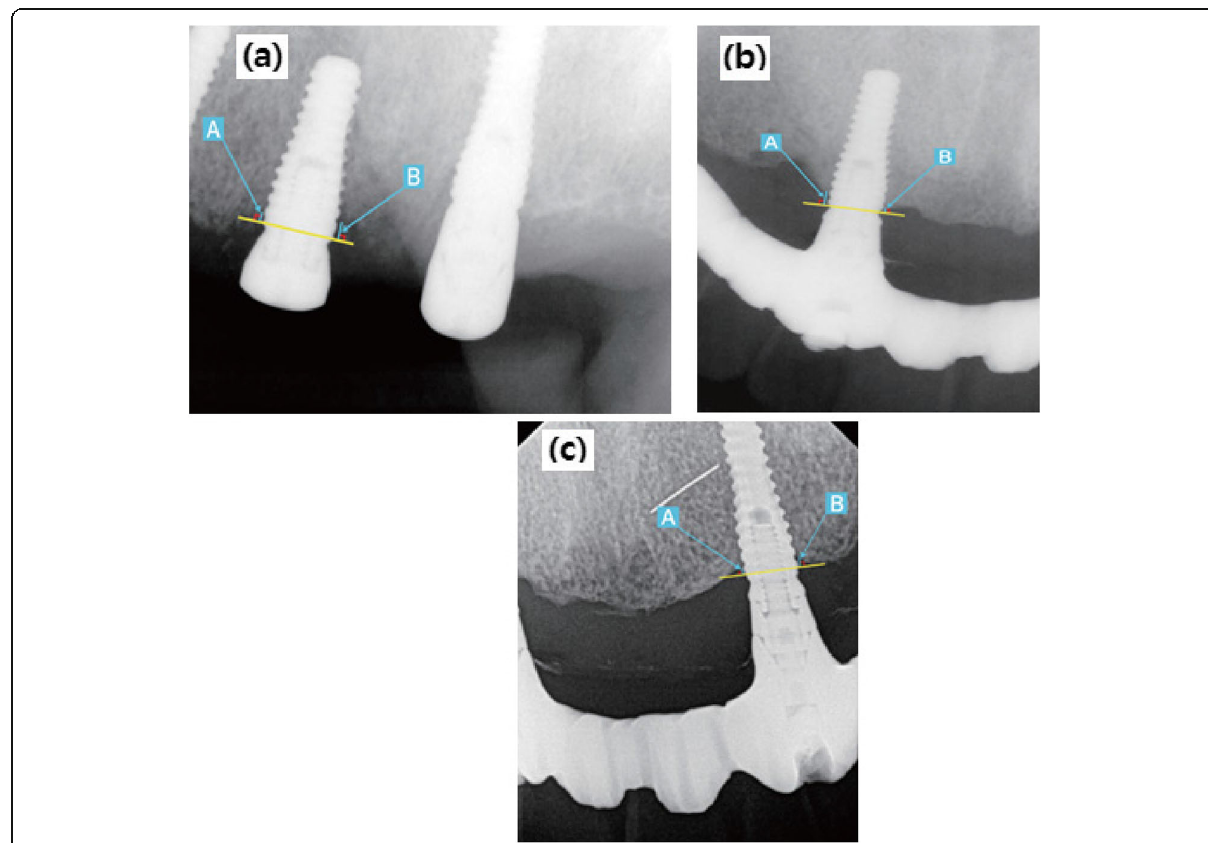
Fig. 2 Landmarks of the radiographic measurements. a Immediately after surgery periapical view. b Periapical view 1 year after prosthetic loading. c Final periapical radiograph. [A point: linear distance from the implant shoulder to the contact point of the implant and bone (mesial surface), B point: linear distance from the implant shoulder to the contact point of the implant and bone (distal surface). The average value of A point and B point was set as the marginal bone loss